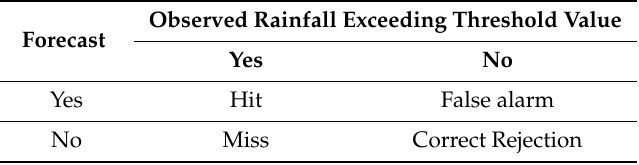
Table 3. Contingency table. Threshold for the wet and the dry seasons is 10 mm and 1 mm, respectively.